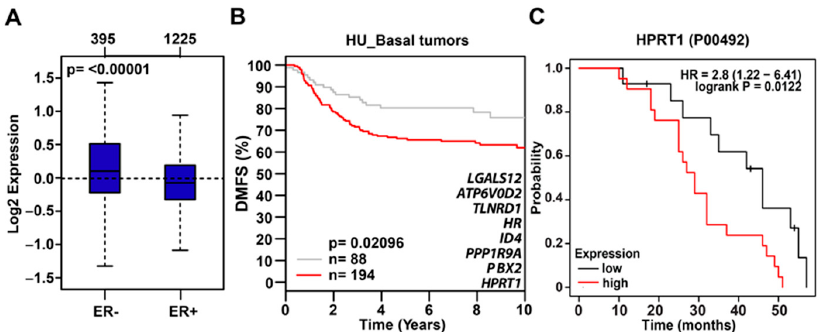
Figure 4. HPRT1 -downregulated gene expression profile in ER- tumors. ( A ) The aggregate expression of HPRT1 and top HPRT1 -downregulated genes ( ≤− 2 fold) preferentially expressed in ER- breast tumor samples. Observed differences are significant as determined by an ANOVA comparison of the means ( p -value < 0.00001). ( B ) Kaplan–Meier analysis (DMFS) using the aggregate expression of HPRT1 and top HPRT1 -downregulated genes ( ≤− 2 fold) showed poor clinical outcome in basal breast cancer patients (red line—higher expression or grey line—lower expression). The cancer outcome linked gene expression data was accessed and graphed in March 2020 using the online tool http://co.bmc.lu.se/gobo/. ( C ) Kaplan–Meier analysis (overall survival) of HPRT1 protein abundance showed poor clinical outcome in triple-negative breast tumors (patient data past 60 months were excluded from the analysis). The cancer outcome-linked protein expression data were accessed and graphed on 4 June 2020, using www.kmplot.com.